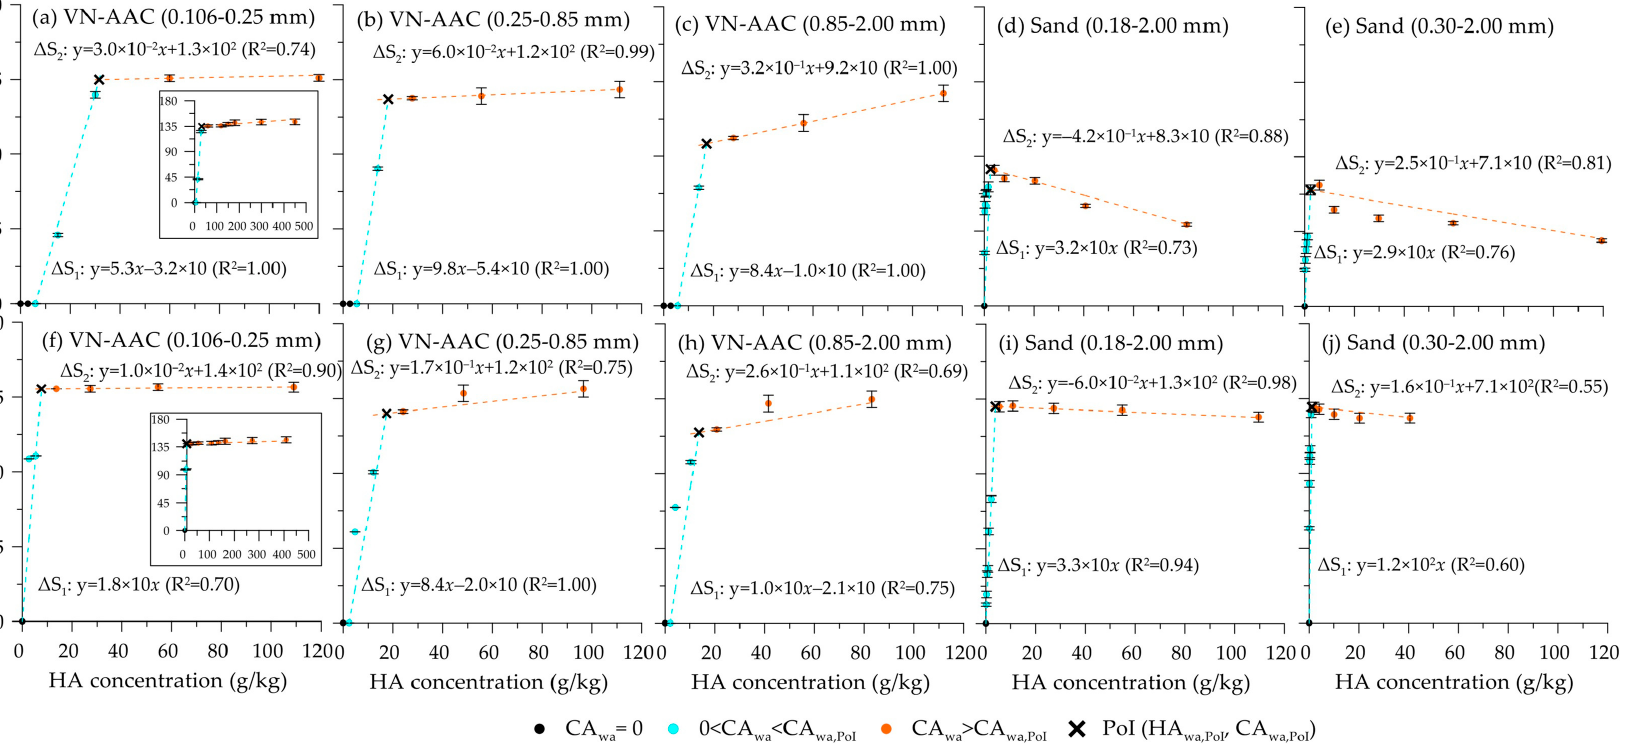
Figure 4. Relationships between CA wa and HA concentrations of OA- and SA-coated VN-AAC grains and sands. OA-coated VN-AAC grains: ( a ) Grain size = 0.106–0.25 mm, ( b ) Grain size = 0.25–0.85 mm, and ( c ) Grain size = 0.85–2.00 mm. OA-coated sands: ( d ) Grain size = 0.18–2.00 mm and ( e ) Grain size = 0.30–2.00 mm. SA-coated VN-AAC grains: ( f ) Grain size = 0.106–0.25 mm, ( g ) Grain size = 0.25–0.85 mm, and ( h ) Grain size = 0.85–2.00 mm. SA-coated sands: ( i ) Grain size = 0.18–2.00 mm, and ( j ) Grain size = 0.30–2.00